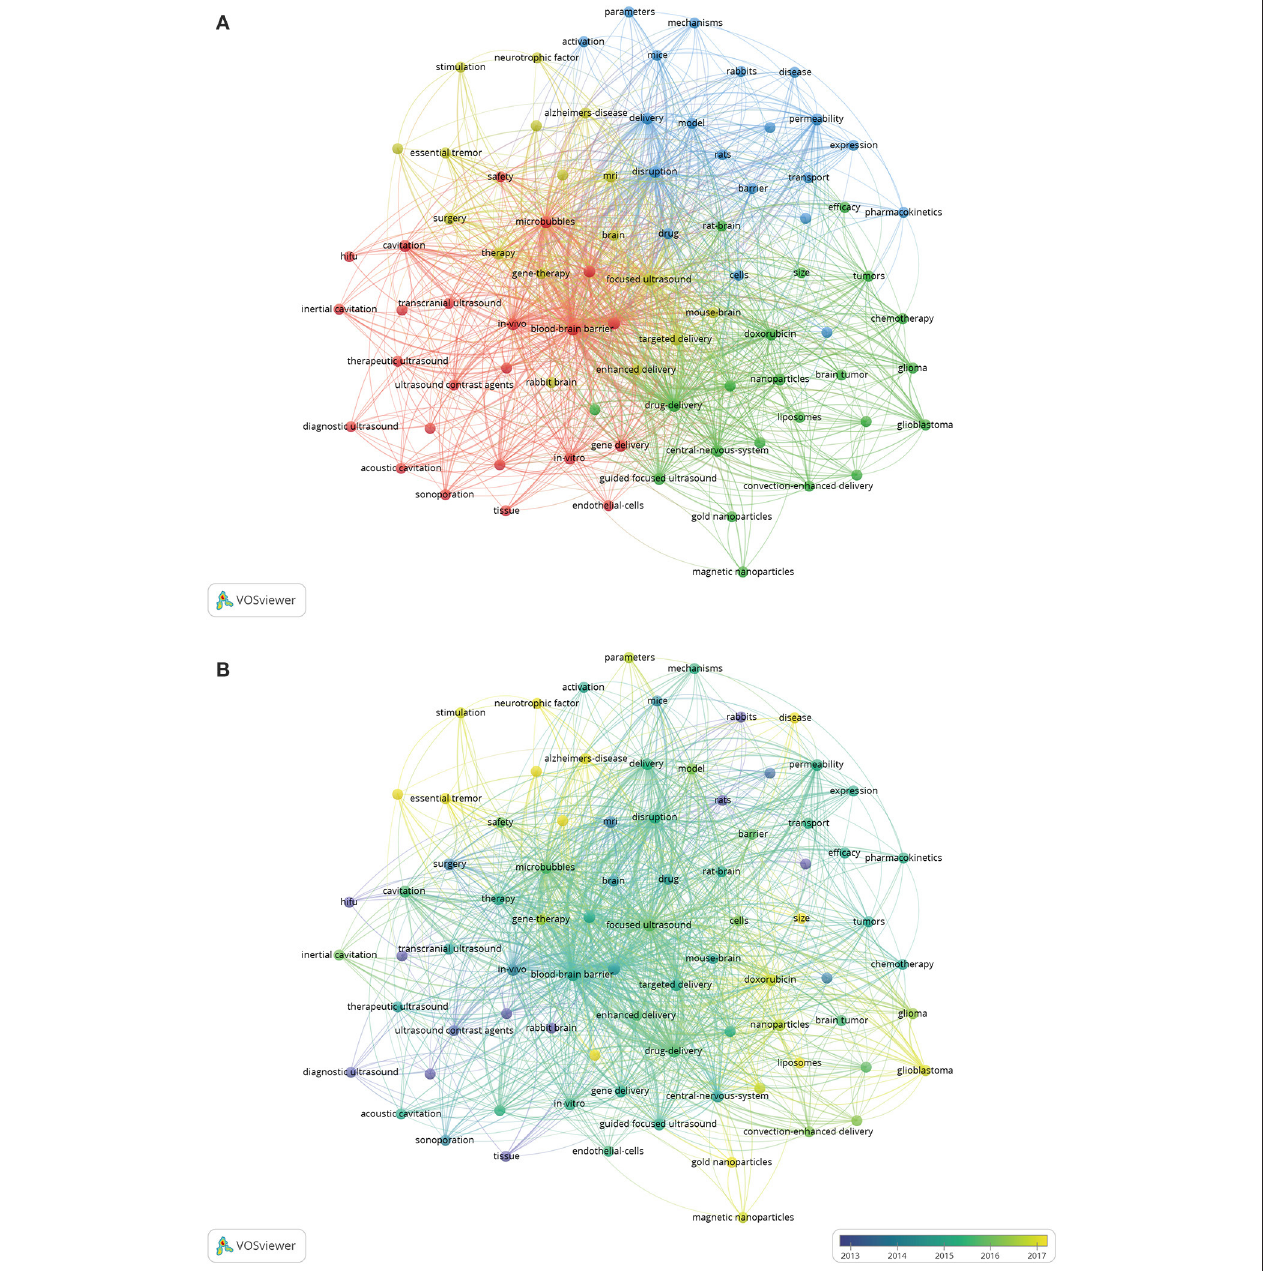
FIGURE 9 | (A) The network visualization map of the 82 keywords generated by using VOS viewer software. All the keywords could be clustered into four categories: cluster 1 (microbubbles study, red nodes), cluster 2 (management of intracranial tumors, green nodes), cluster 3 (ultrasound parameters and mechanisms study, blue nodes), and cluster 4 (treatment of neurodegenerative diseases, yellow nodes). (B) The overlay visualization map of the 82 keywords generated by using VOS viewer software. The nodes coded with purple and blue color represented the keywords that appeared relatively earlier upon time course before or around 2013, whereas keywords that appeared around 2015 were coded with green color and those frequently used around or after 2017 appeared in yellow.